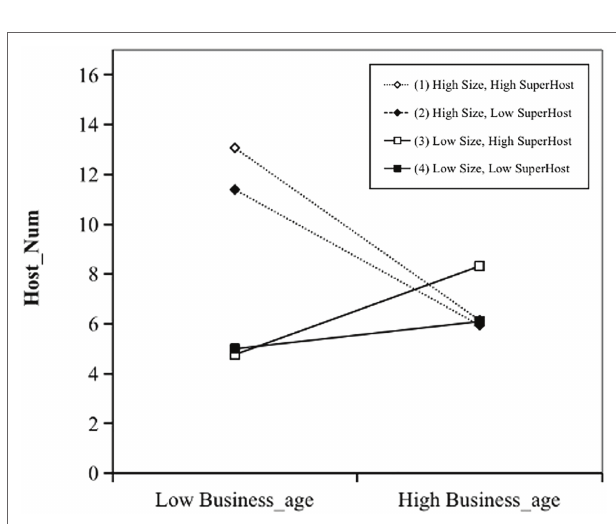
FIGURE 2 | Three-way interaction of business age, size, and host reputation on host